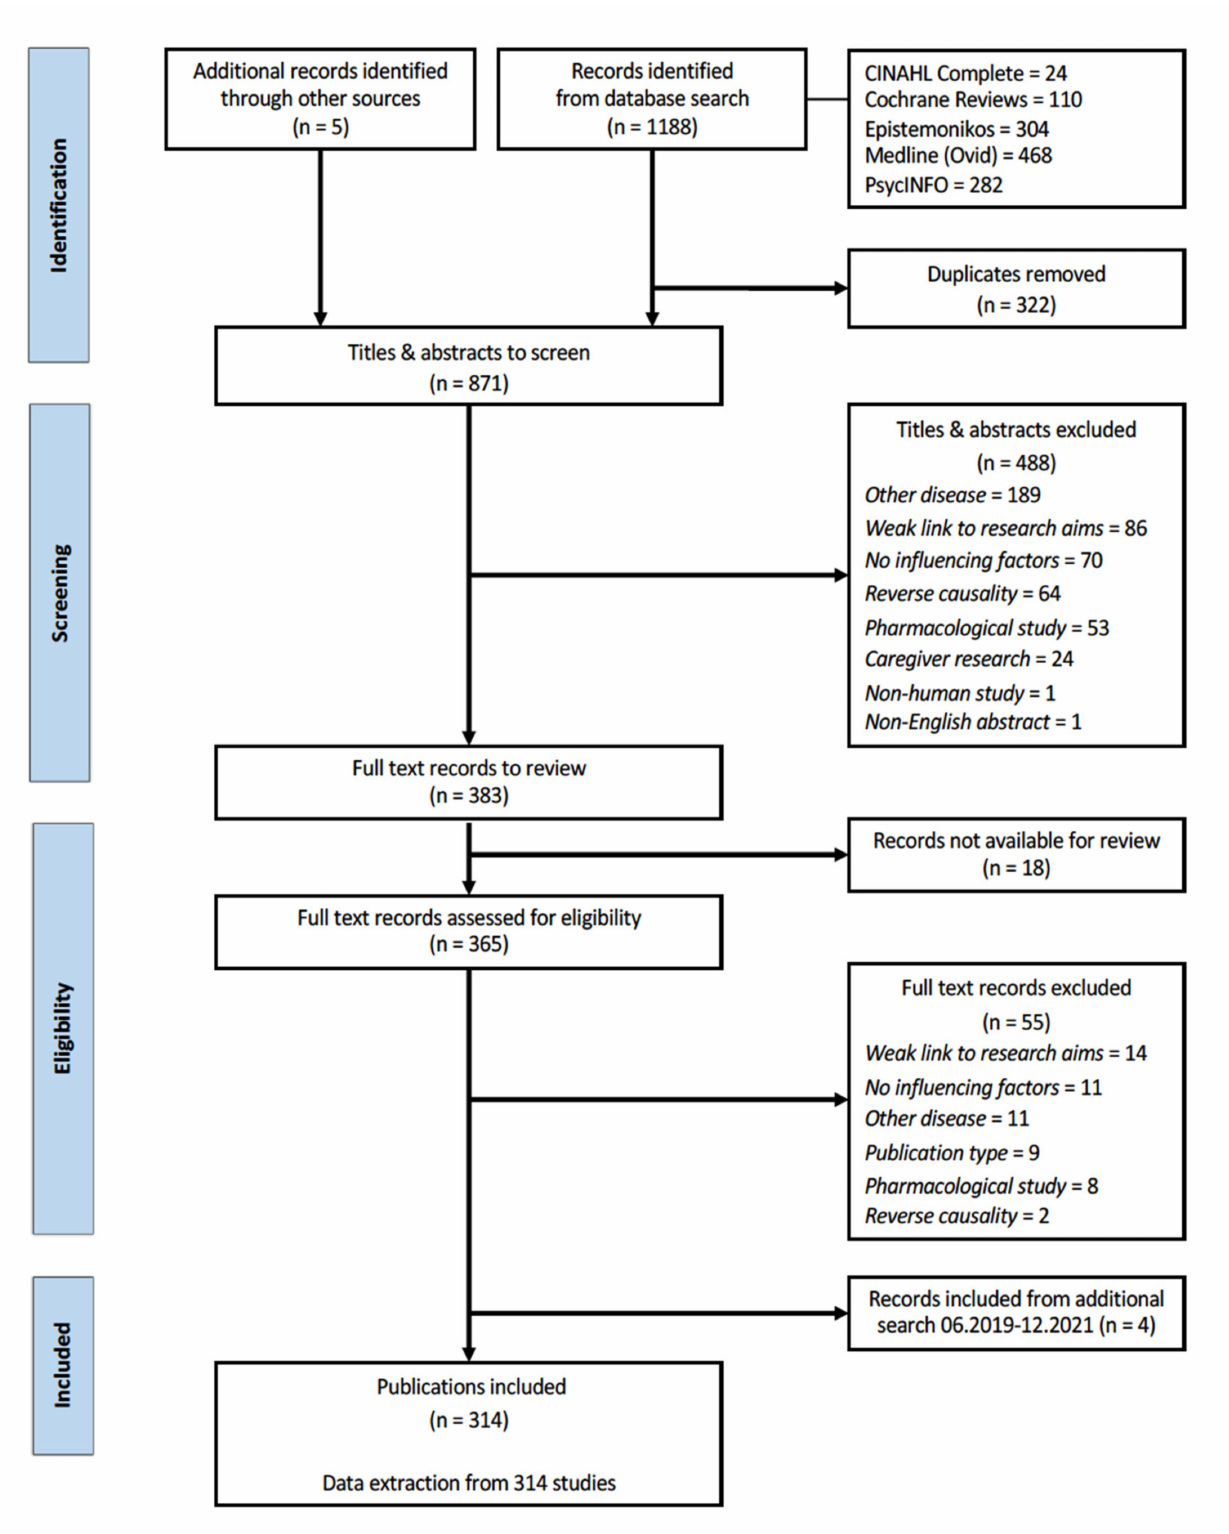
Figure 1. PRISMA Flow